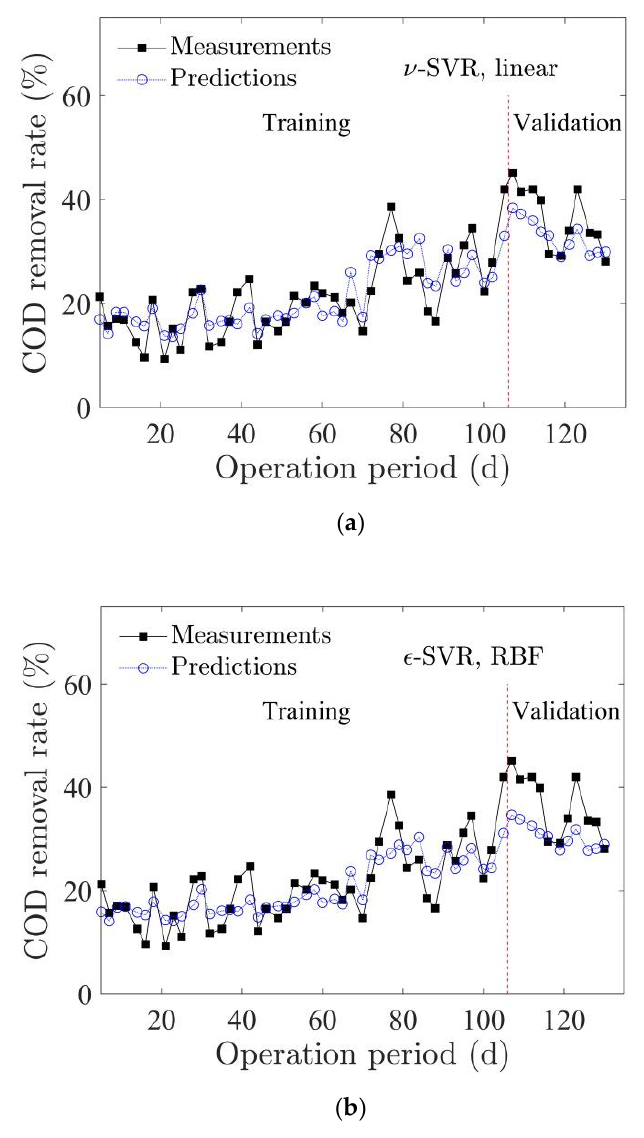
Figure 6. Comparison between the experimental measurements and the predictions by the SVR on the COD removal rate during the reactor operation period. The regression mode was ν -SVR with linear kernel function in ( a ), and ε -SVR with RBF kernel function in ( b ), respectively. Table 3. Performance of ν -SVR and ε -SVR with three types of kernel functions on the prediction of COD removal